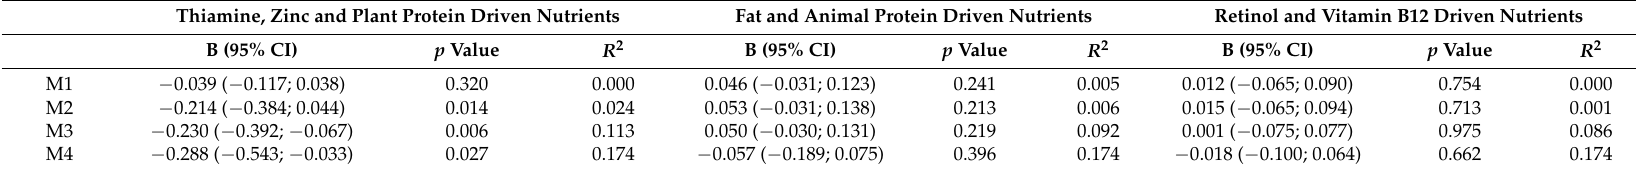
Table 6. Regression coefficients for glycated haemoglobin for 1 SD increase in the derived nutrient pattern scores among rural black South African women. Thiamine, Zinc and Plant Protein Driven Nutrients Fat and Animal Protein Driven Nutrients Retinol and Vitamin B12 Driven Nutrients B (95%